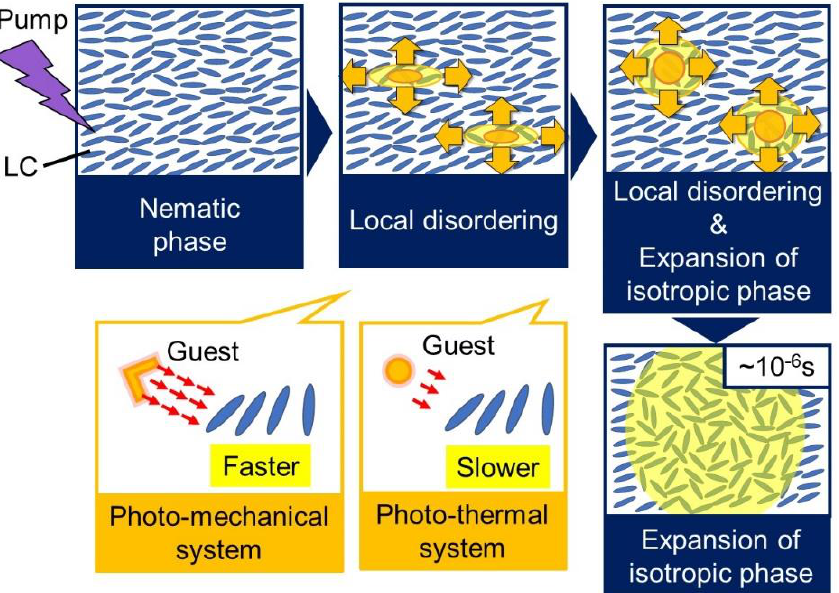
Figure 11. The schematic model illustration of the phase transition for the dye-doped LCs is summarized.